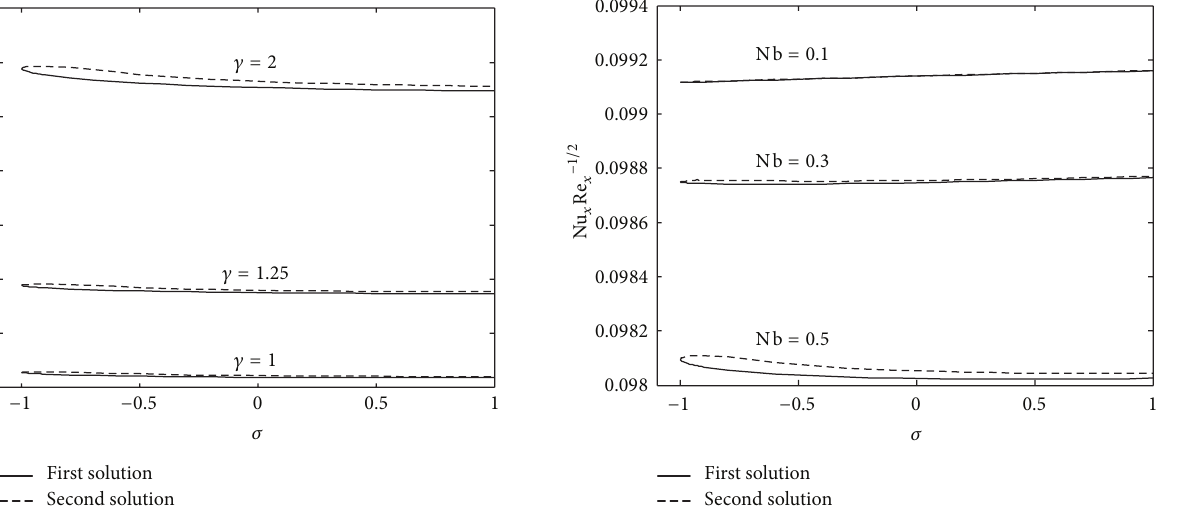
Figure 2: Variations of the local Nusselt number (heat transfer rate) with 𝜎 for different values of 𝛾 when Nb = Nt = 0.5, Le = 2, Pr = 6.8, and S = 2.